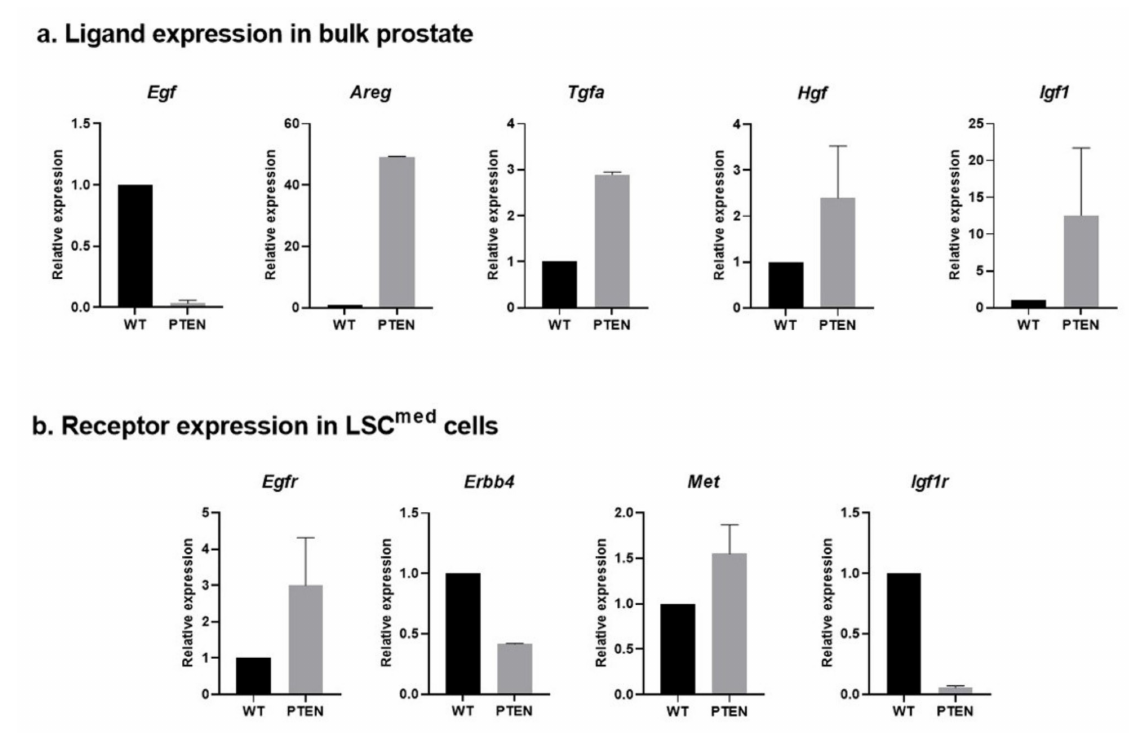
Figure 5. Relative expression of EGFR/ERBB4, MET and IGF-1R ligands ( a ) and receptors ( b ) in Pten-null prostates versus WT prostates. Expression of Egfr , Erbb4 , Met and Igf1r in sorted LSC med cells and of their ligands in bulk prostate was determined by RT-qPCR. Data obtained from 2 ( a ) and 3 (Pten-null) to 15 (WT) animals ( b ) are presented as 2 − ∆∆ Ct normalized to WT mouse